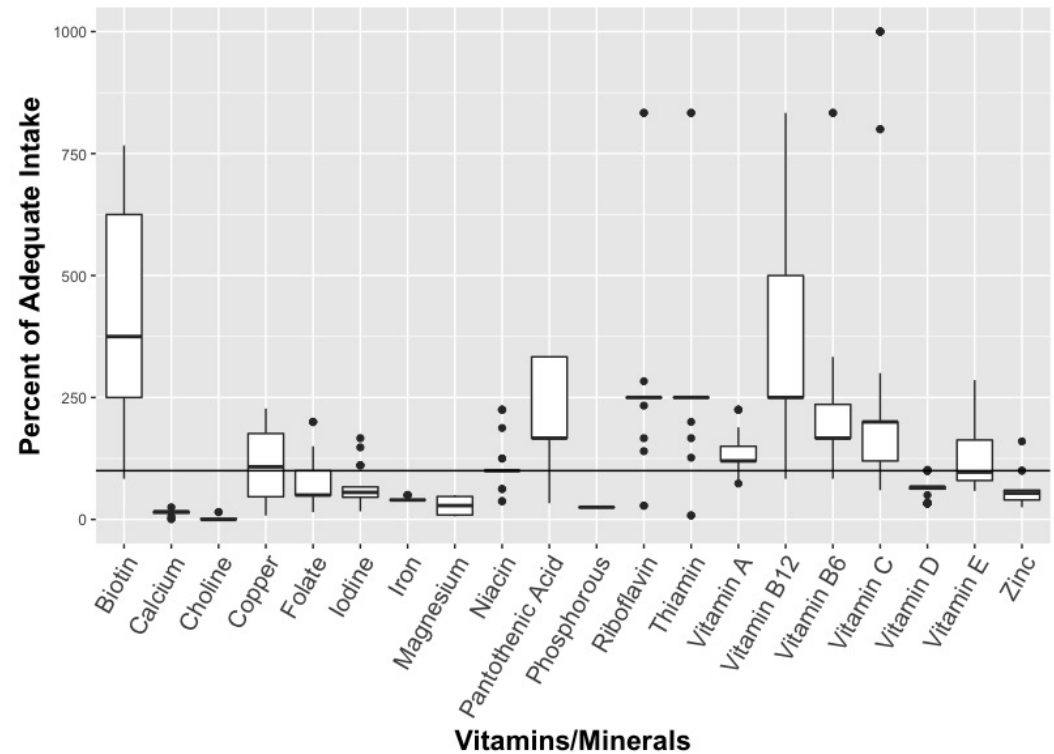
Figure 2. Percent of recommended vitamins/minerals for children aged 4 and up in multivitamin supplements (n = 52). * Solid line represents median estimate, with top and bottom of box representing the quartiles (if sufficient data). Y—axis was truncated at 1000% to allow appropriate visualization of the estimates.